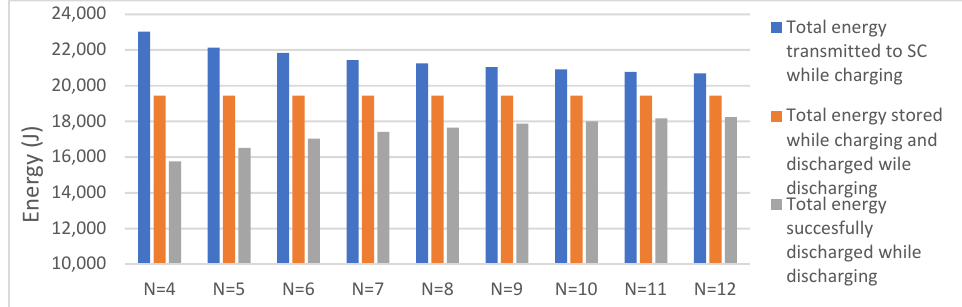
Figure 18. Comparative diagrams of total transmitted, stored, and successfully discharged energies of the SC circuit at different numbers of phases.